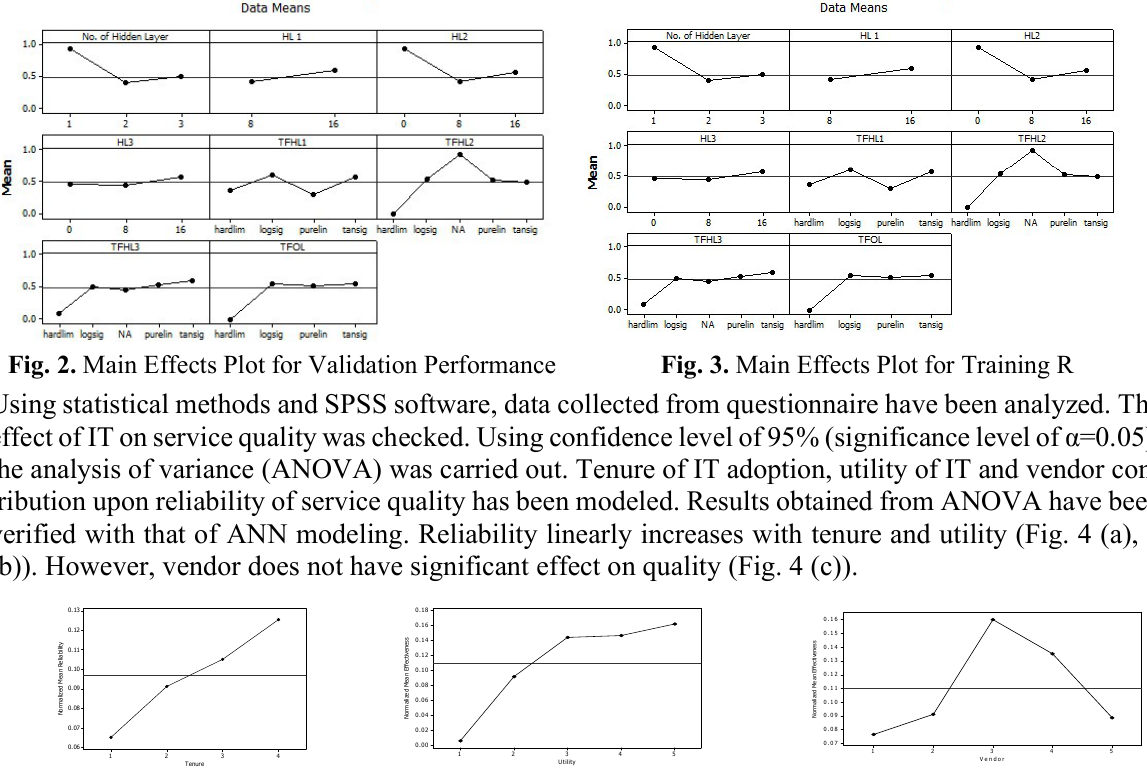
Fig. 4 (a). Tenure vs. Reliability Fig. 4 (b). Utility vs. Reliability Fig. 4 (c). Vendor developed IT